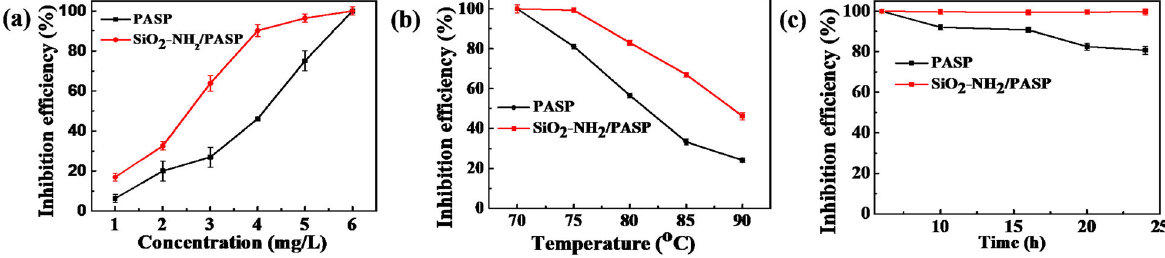
Fig. 3 Inhibition ef fi ciency of PASP and SiO 2 – NH 2 /PASP against CaSO 4 scale. a different inhibitor concentration, b different test temperature, c different test time. Error bars indicate the standard deviation.